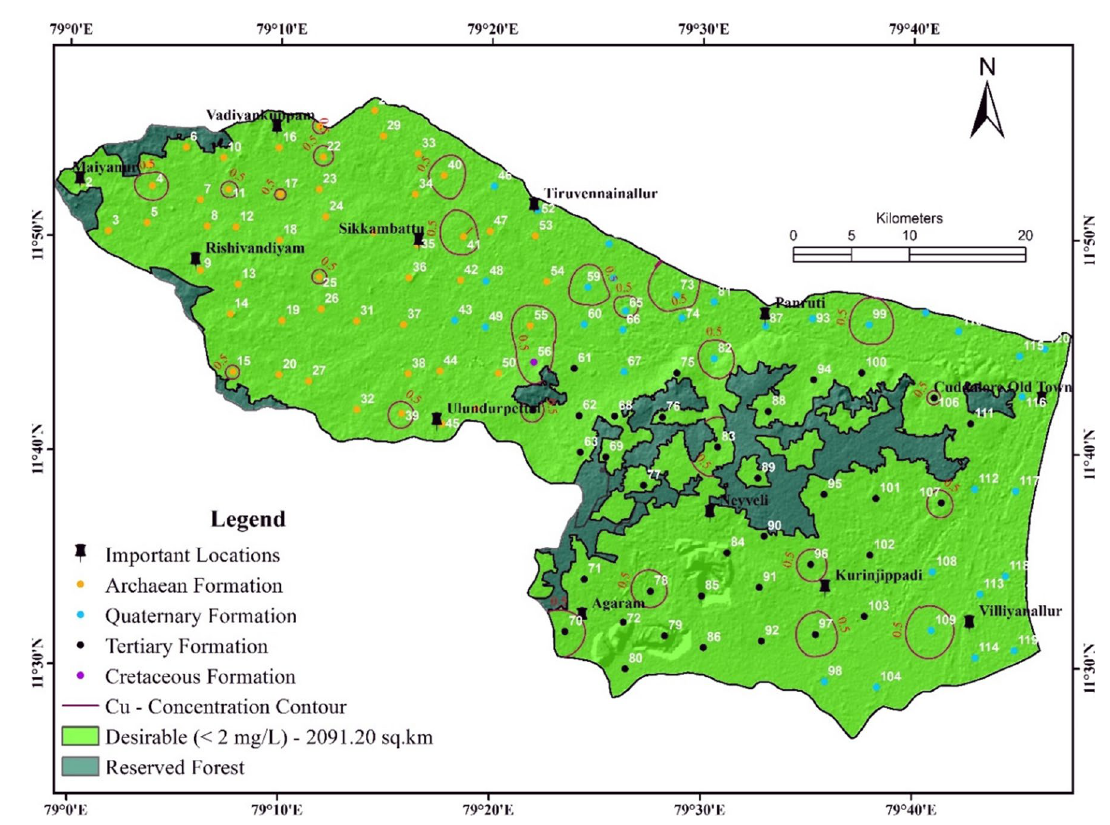
Fig. 8 Spatial variation with contour map of copper in